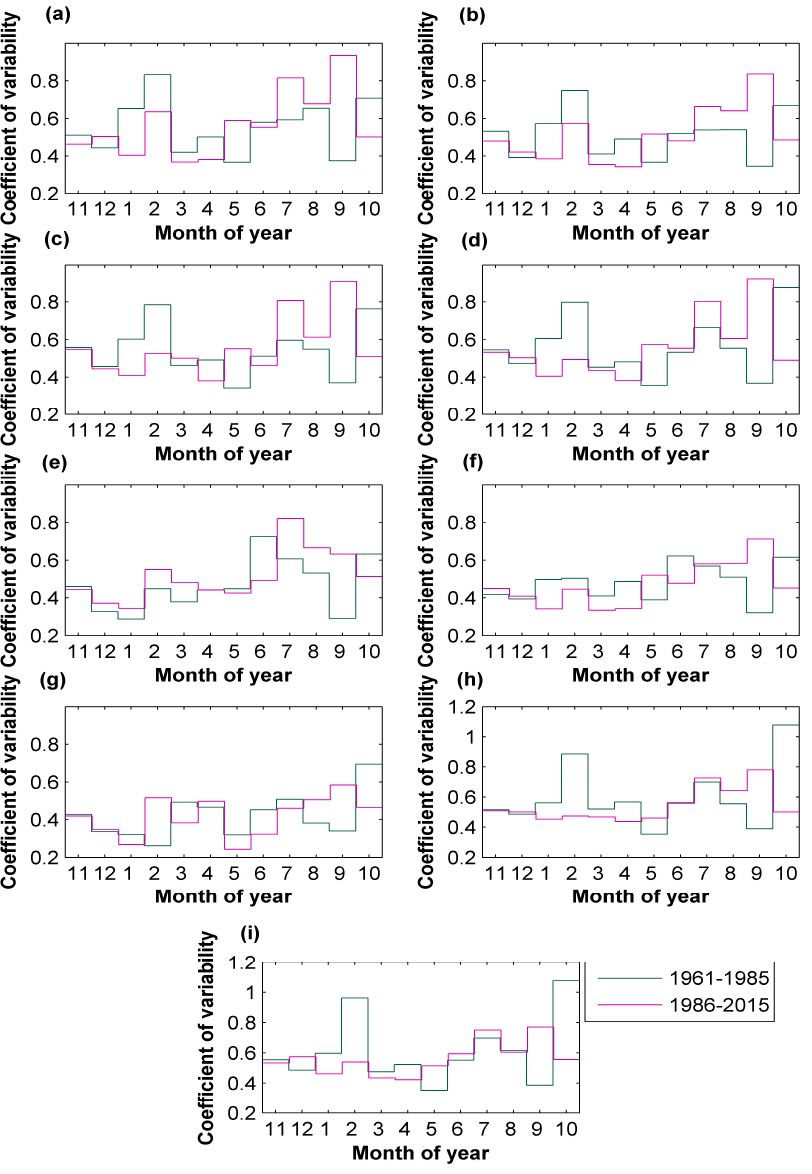
Figure 5. Variability of river flow for two subsequent periods at ( a ) Nowy Targ; ( b ) Nowy Targ-Kowaniec; ( c ) Kro ś cienko; ( d ) Nowy S ą cz; ( e ) Zakopane ‐ Harenda; ( f ) Szaflary; ( g ) Ł ysa Polana; ( h ) Muszyna; and ( i ) Stary S ą cz. Between the time periods 1986–2015 and 1961–1985, significant differences in the variability of river flow were identified for September (an increase) and for October (a decrease).